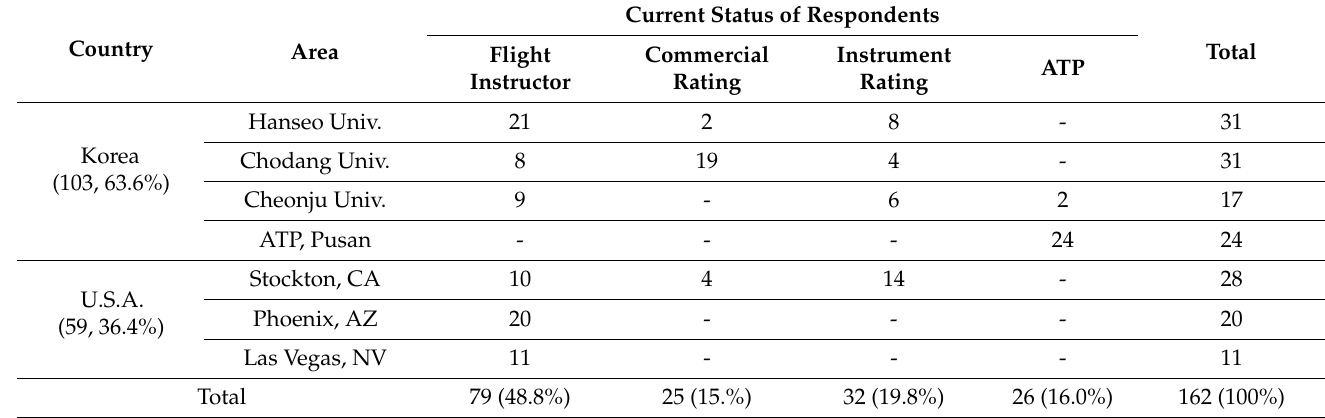
Table 1. Samples of